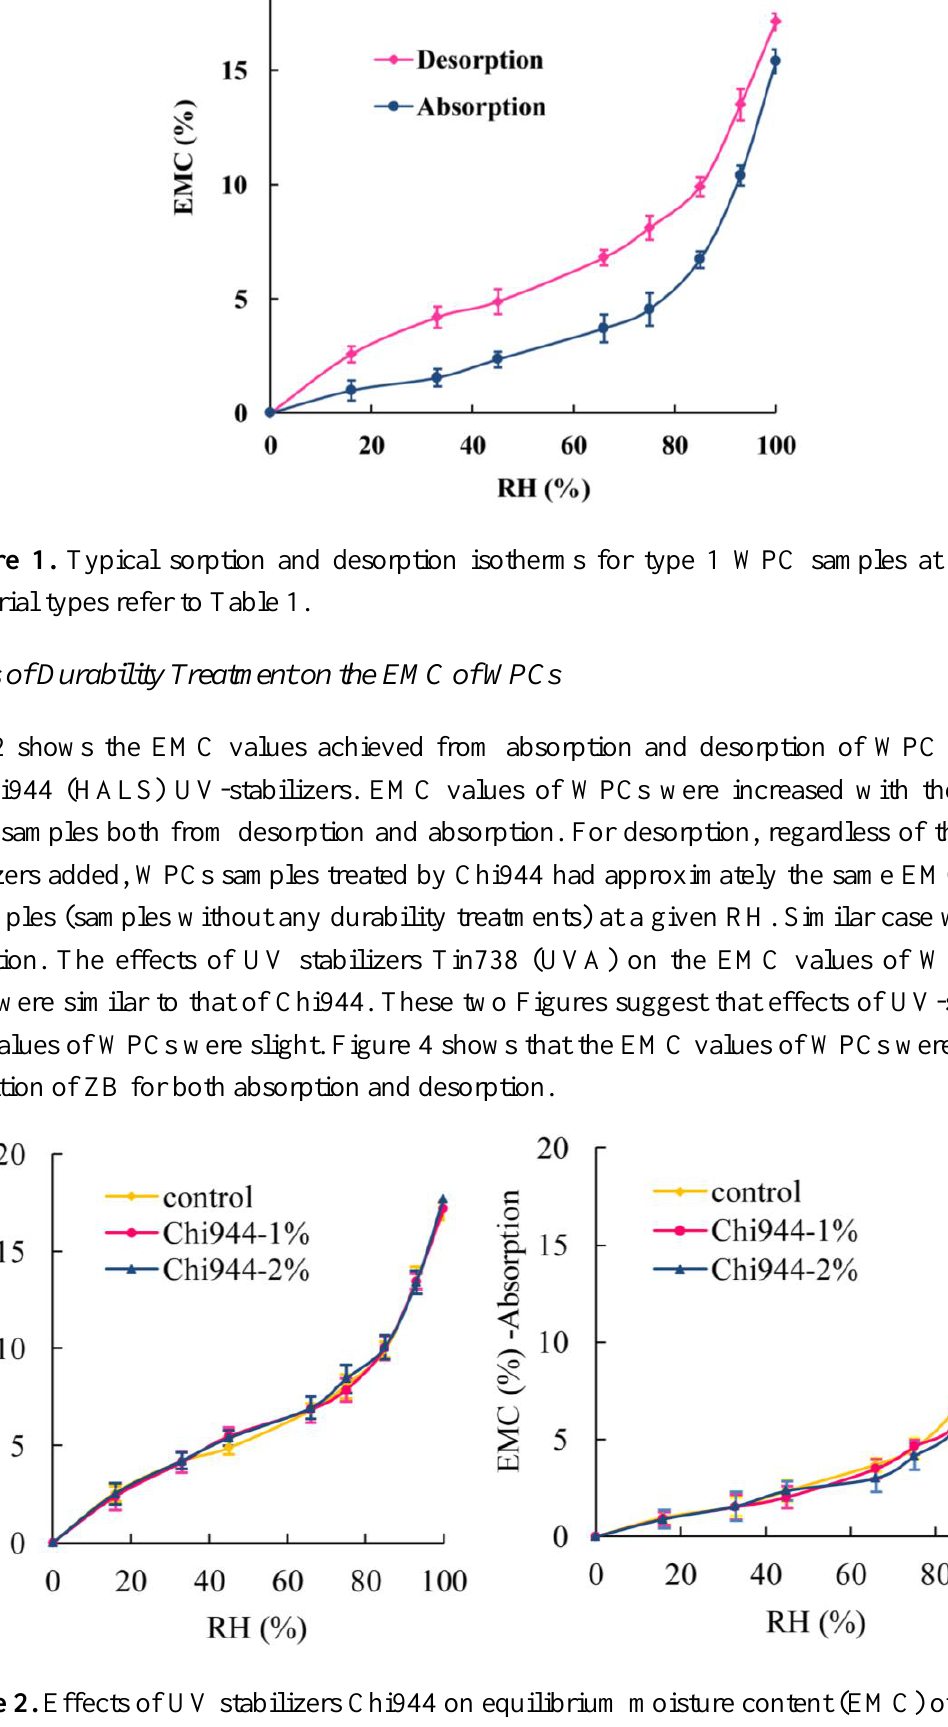
Figure 2. Effects of UV stabilizers Chi944 on equilibrium moisture content (EMC) of